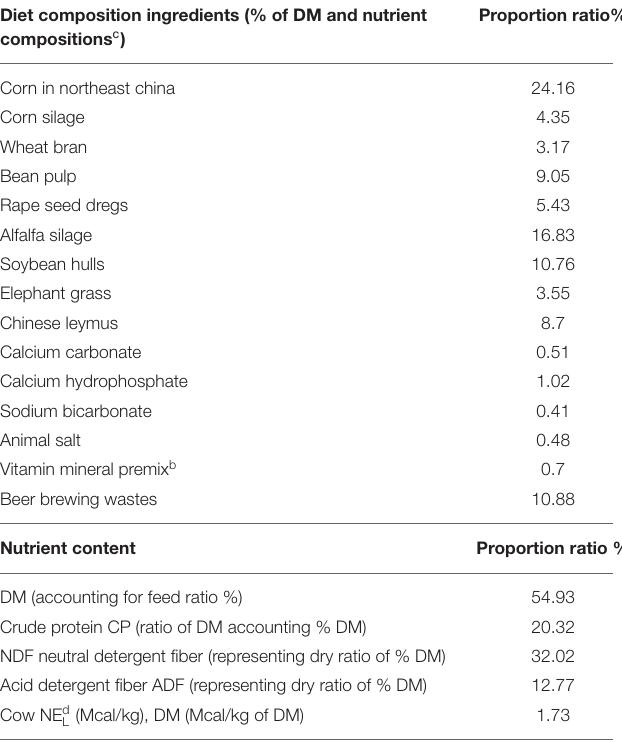
TABLE 1 | The ingredients and chemical composition of experimental feedstuffs a of diets/rations during the peripartum period of dairy cows.